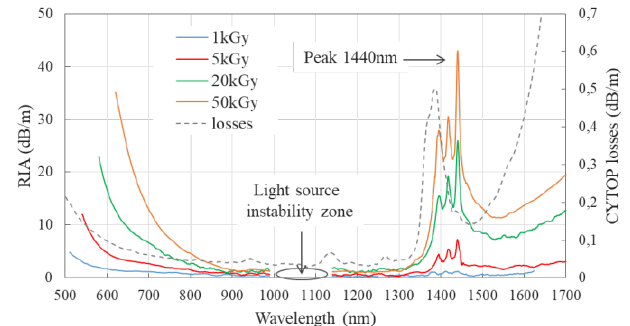
Fig. 4. CYTOP fiber RIA measured 5 months after irradiation.